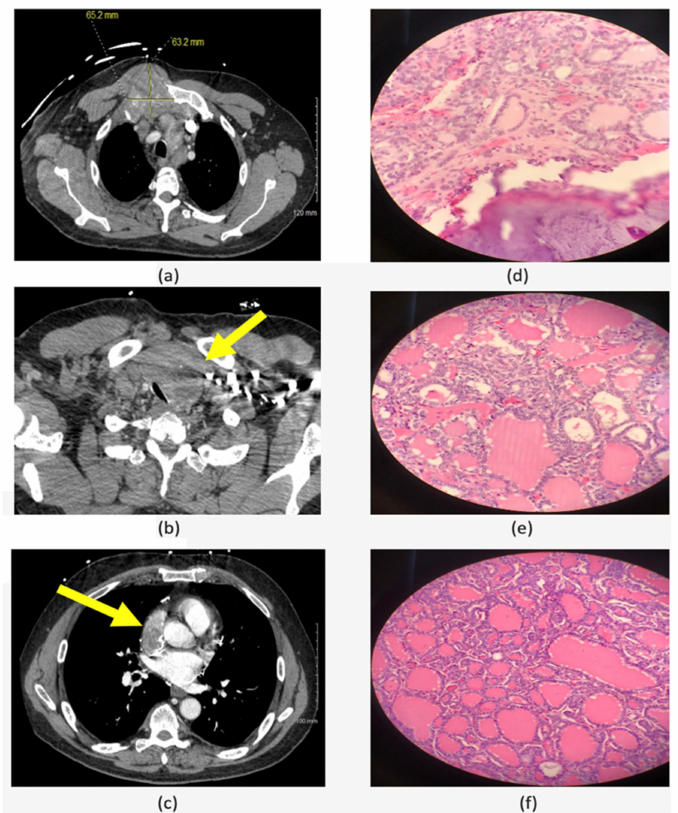
Figure 3. Left column is showing the neck and chest CT scan: ( a ) 6.5 cm right manubrial costal junction mass; ( b ) left thyroid lobe mass with tracheal compression ( c ) 5.1 cm superior vena cava (SVC)/right arterial mass. Right column is showing the final pathology from all the resected sites which showed follicular variant of papillary thyroid carcinoma: ( d ) chest wall metastasis; ( e ) left thyroid tumor; ( f ) right atrium